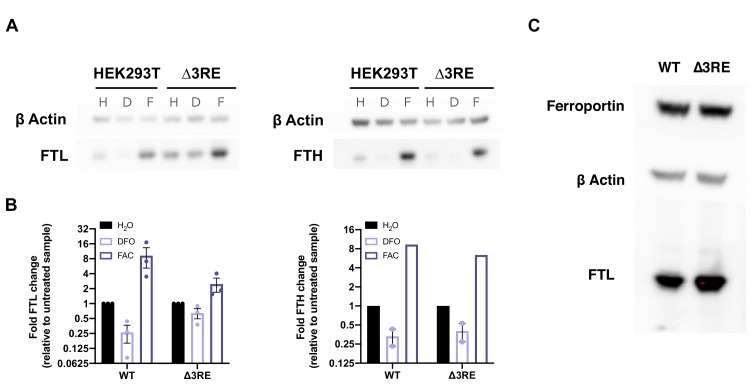
Quantification of FTL and FTH protein levels in HEK293T cells.(A) Representative western blots comparing the levels of FTL and FTH in wild type vs ∆3RE under different iron treatment conditions. Iron donor treatment with FAC at 50 µg/mL for 24 hr or iron chelation treatment with DFO at 200 µM for 24 hr. (B) Quantification of western blots comparing the levels of FTL and FTH in wild type vs ∆3RE HEK293T cells. Three biological replicates are shown with error bars representing standard error of the mean for both of the FTL data sets. There are two biological replicates for FTH levels under DFO treatment and error bars represent standard error of the mean. There was only one quantifiable replicate for the ∆3RE FAC treatment. (C) Representative western blots comparing the levels of ferroportin in wild type vs ∆3RE (HepG2) cells under various iron conditions.10.7554/eLife.48193.020Figure 3—figure supplement 5—source data 1.Western blot quantification of FTL and FTH in HEK293T cells.